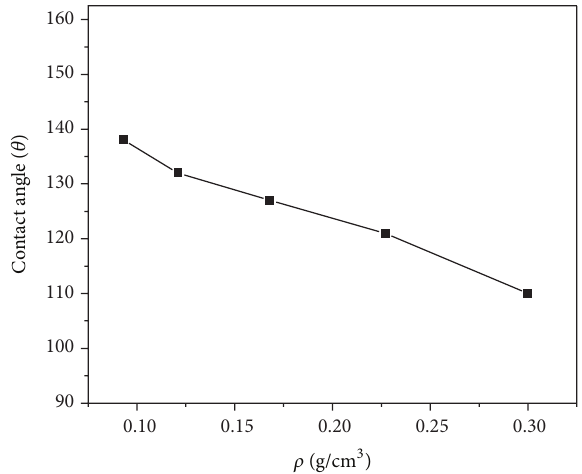
Figure 6: Water contact angle versus aerogel density.